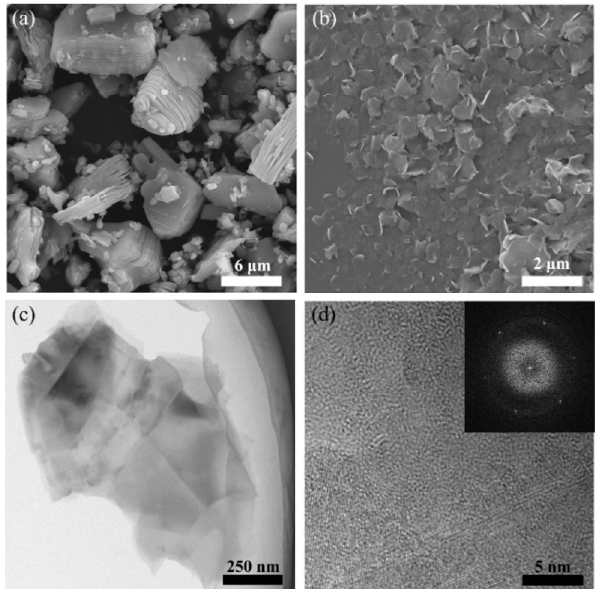
Fig. 2 SEM images of (a) mult-layer Ti 3 C 2 MXene after etching and (b) few-layer Ti 3 C 2 MXene after peeling, (c) TEM and (d) high-resolution TEM images of few-layer Ti 3 C 2 MXene, the inset of (d) is the corresponding FFT of the thin Ti 3 C 2 MXene nanosheets.